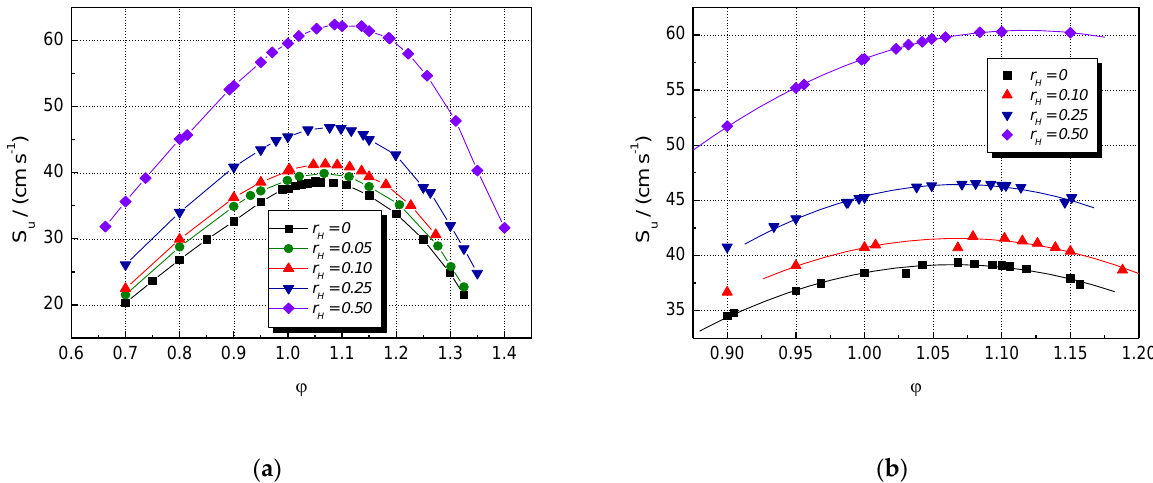
Figure 5. Computed laminar burning velocities of single fuel – air and multifuel – air mixtures with various 𝑟 𝐻 at ambient p 0 and T 0 : ( a ) CH 4 – H 2 – air ( b ) NG – H 2 – air mixtures.